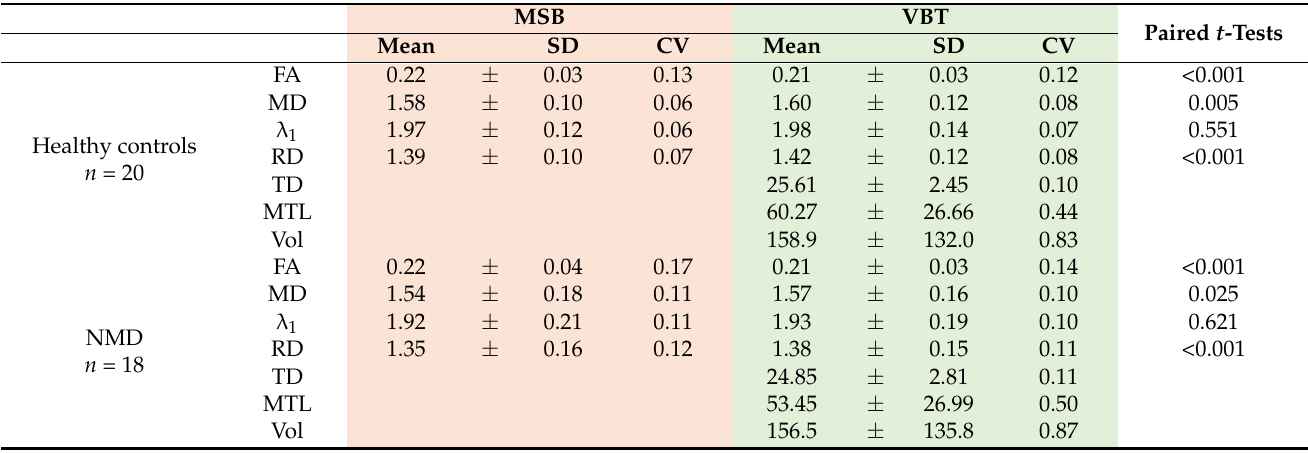
Table 1. Overview of DTI parameters, tract properties and coefficient of variation (CV) for segmentation tech- niques. MSB = manual segmentation-based analysis, VBT = volume-based tractography, CV = coefficient of variance, NMD = neuromuscular diseases, TD = tract density, MTL = mean tract length, Vol = volume.